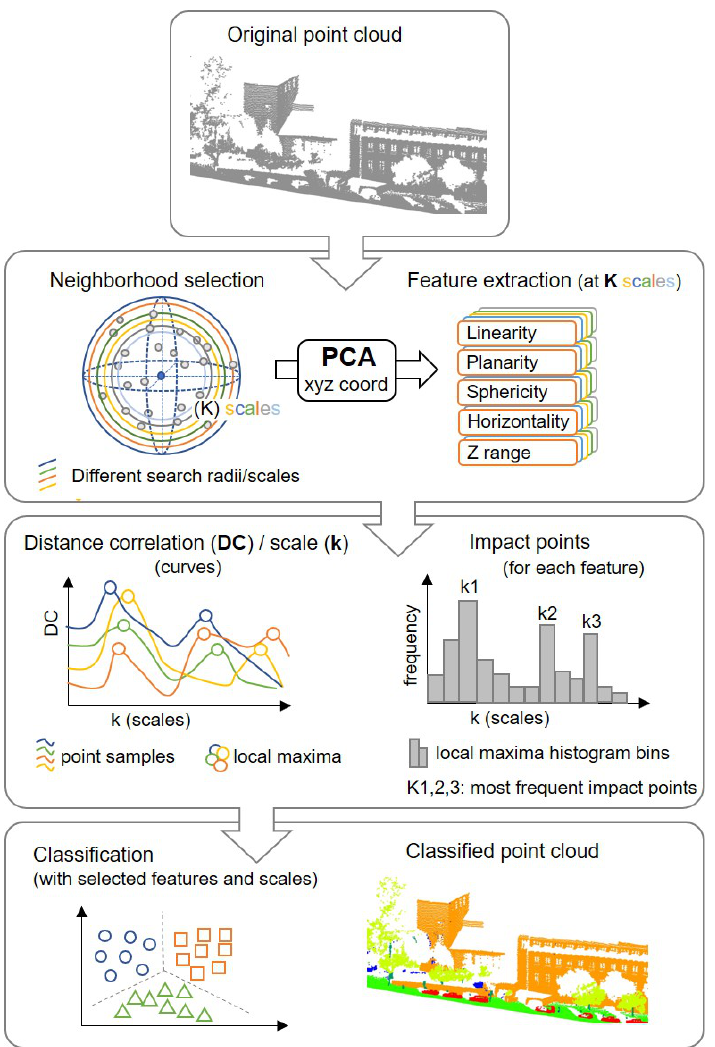
Figure 6. Workflow of the proposed methodology to select the optimum scales (impact points) and perform the multiscale